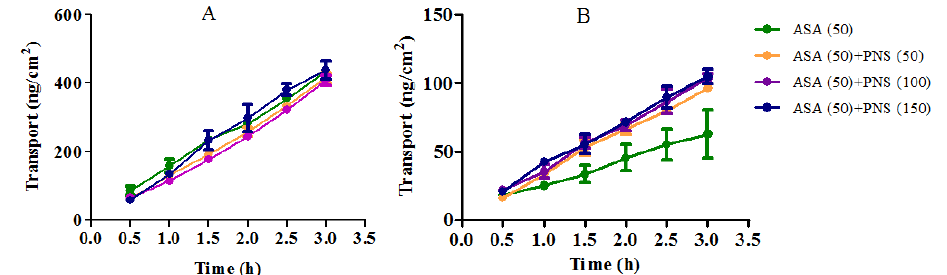
Figure 5. Effects of Panax notoginseng saponins (PNS) on aspirin (ASA) transport across Caco-2 cell monolayers from apical ( A ) to basolateral ( B ) side. Washed Caco-2 cell monolayers were pre-incubated for 20 min in HBSS. ASA (50 μg/mL) in HBSS with different concentrations of PNS was loaded on A side, and blank HBSS was loaded on B side. ( A ) Cumulative transport amount of ASA and ASA deduced from converted salicylic acid from A → B transport. ( B ) Cumulative transport amount of ASA from A → B transport. Samples were collected at 0.5, 1.0, 1.5, 2.0, 2.5 and 3.0 h from B side. Data were presented as mean ± SD ( n = 3).